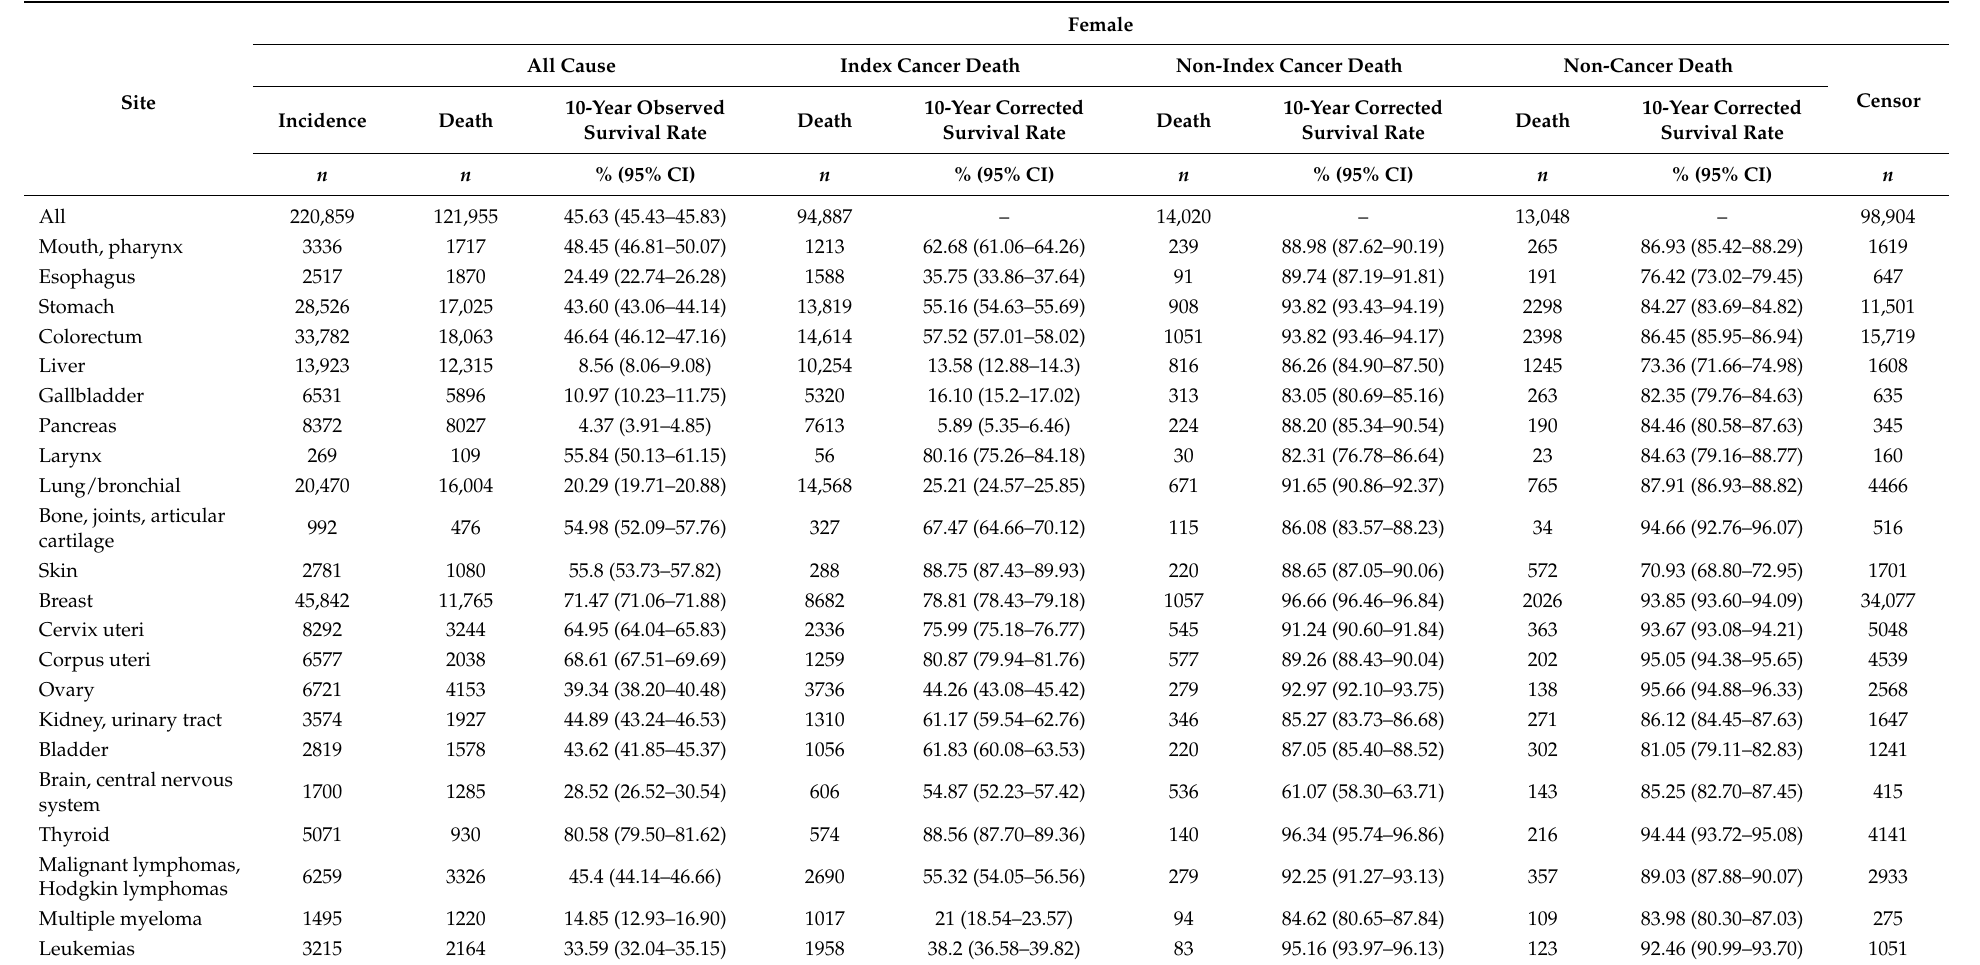
Table 3. Summary of cancer morbidity and 10-year cancer mortality by cause of death (female, incidence: 1995–2011, death or survival: